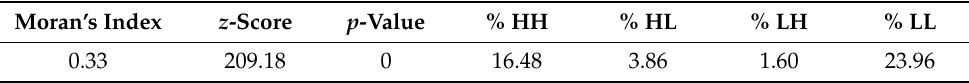
Table 4. Spatial autocorrelation of spatial accessibility to PHC facilities.